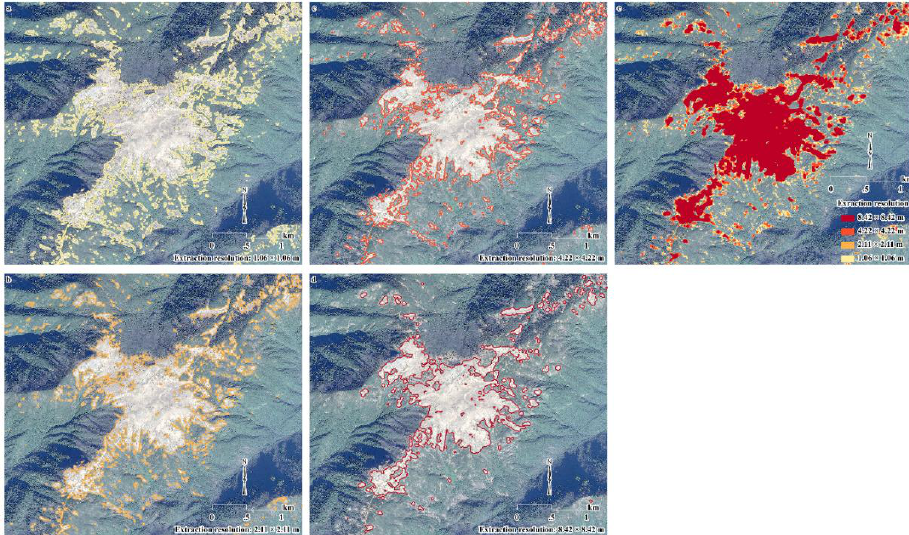
Figure 7. Tree line extraction from RGB (Red, Green and Blue) images (true-color composition images acquired on 23 December 2014) with di ff erent spatial resolutions (1.06 × 1.06 ( a ), 2.11 × 2.11 ( b ), 4.22 × 4.22 ( c ), and 8.42 × 8.42 m ( d